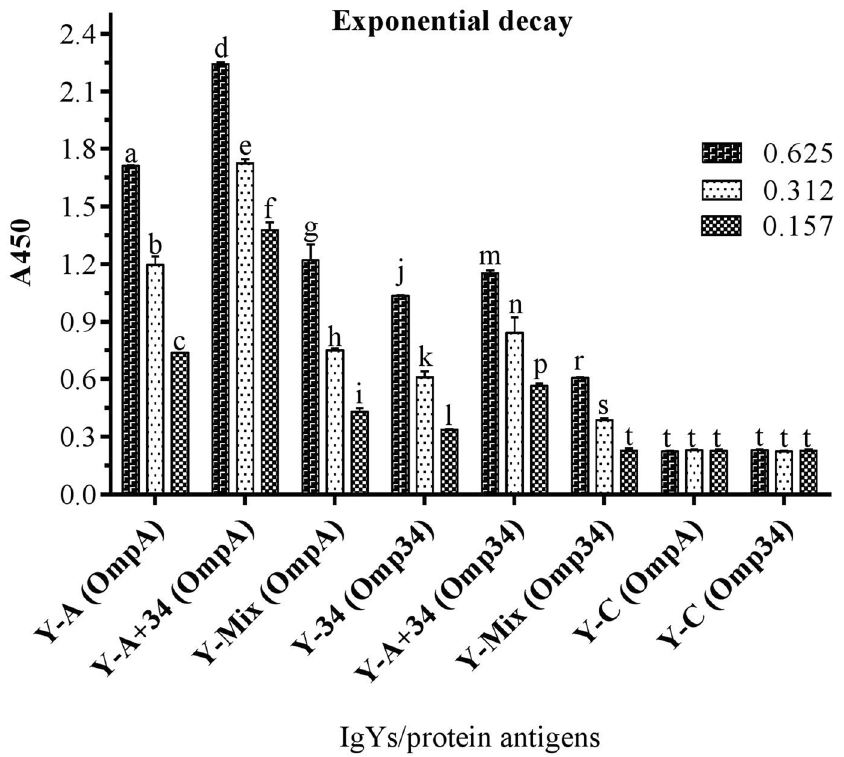
Figure 3. ELISA of specific IgYs against recombinant proteins to assay synergic effect of the antigens. Two micrograms of antigens were coated. OmpA and Omp34 in parentheses show coated antigens. Three levels of IgYs (0.625, 0.312 or 0.157 µg/well) were assessed. Y-A: IgYs raised against rOmpA, Y-34: IgYs raised against rOmp34, Y-A + 34: IgYs raised against combination of rOmpA34 and rOmp34 in 1:1 ratio, Y-Mix: mixture of Y-A and Y-34 in 1:1 ratio, and Y-C: control IgY. Mean values ± S.E are from independent groups and values superscripted by different letters are significantly different by Duncan’s multiple range tests ( P ≤